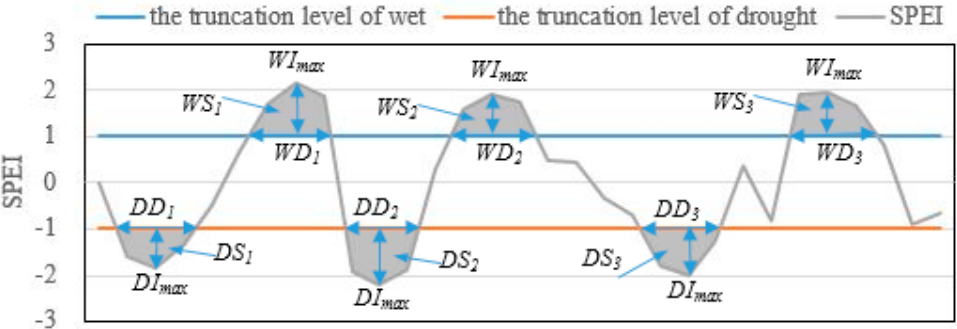
Figure 2. Drought or wet events and relevant characteristic variables by the run theory.